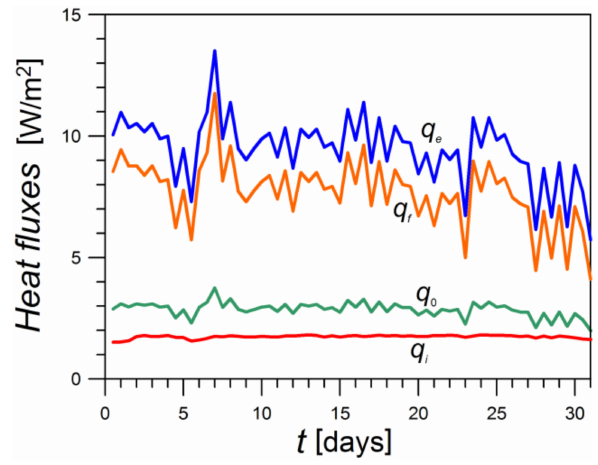
Figure 15. Temporal courses of heat fluxes q i , q e , q f , and q 0 .